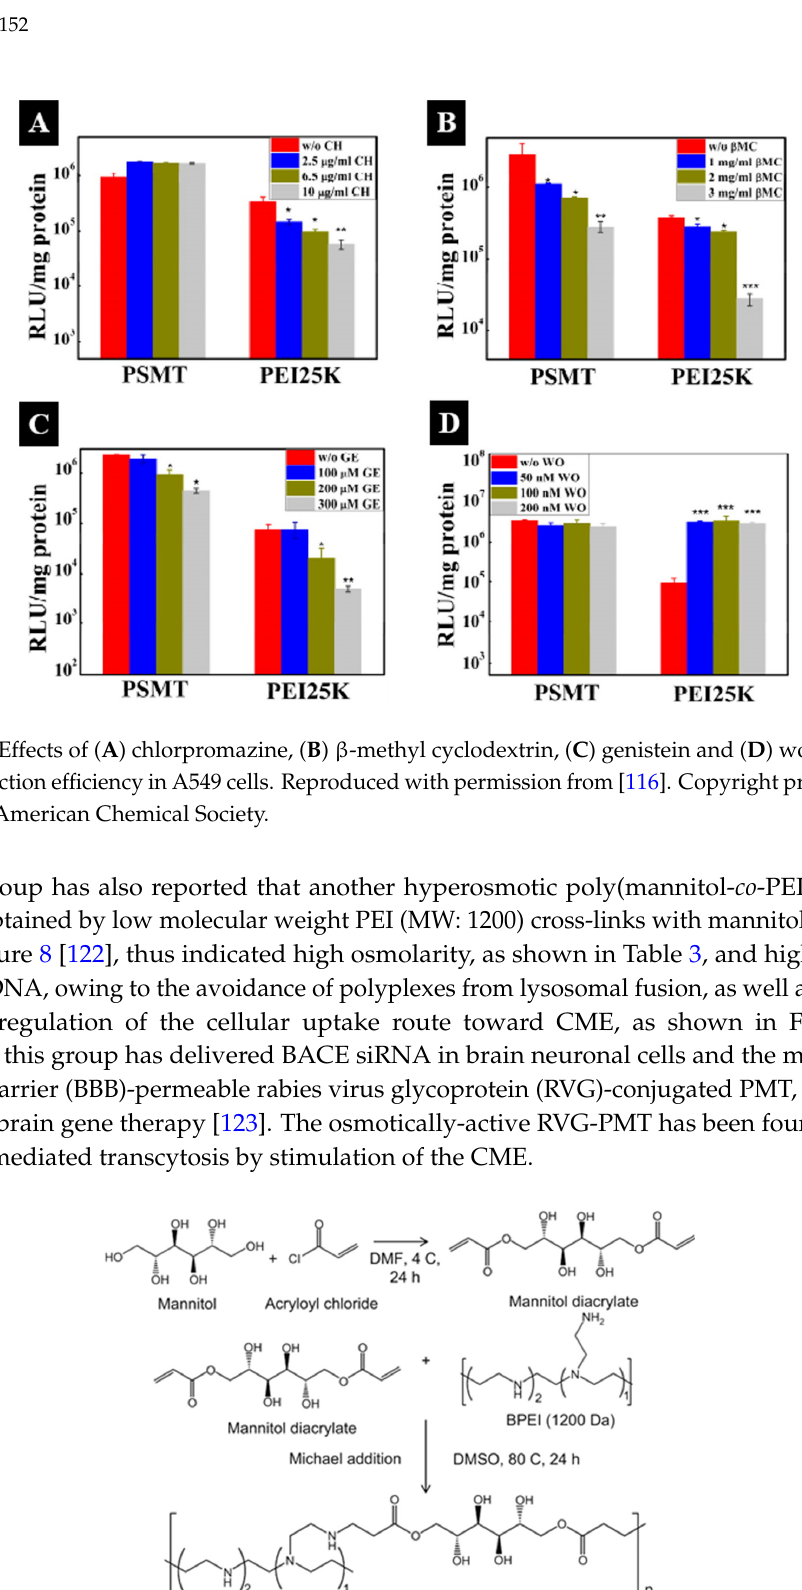
Figure 8. Schematic representation of the synthesis of poly (mannitol- co -PEI) (PMT). Reproduced with permission from [122] Copyright proceedings from Elsevier).